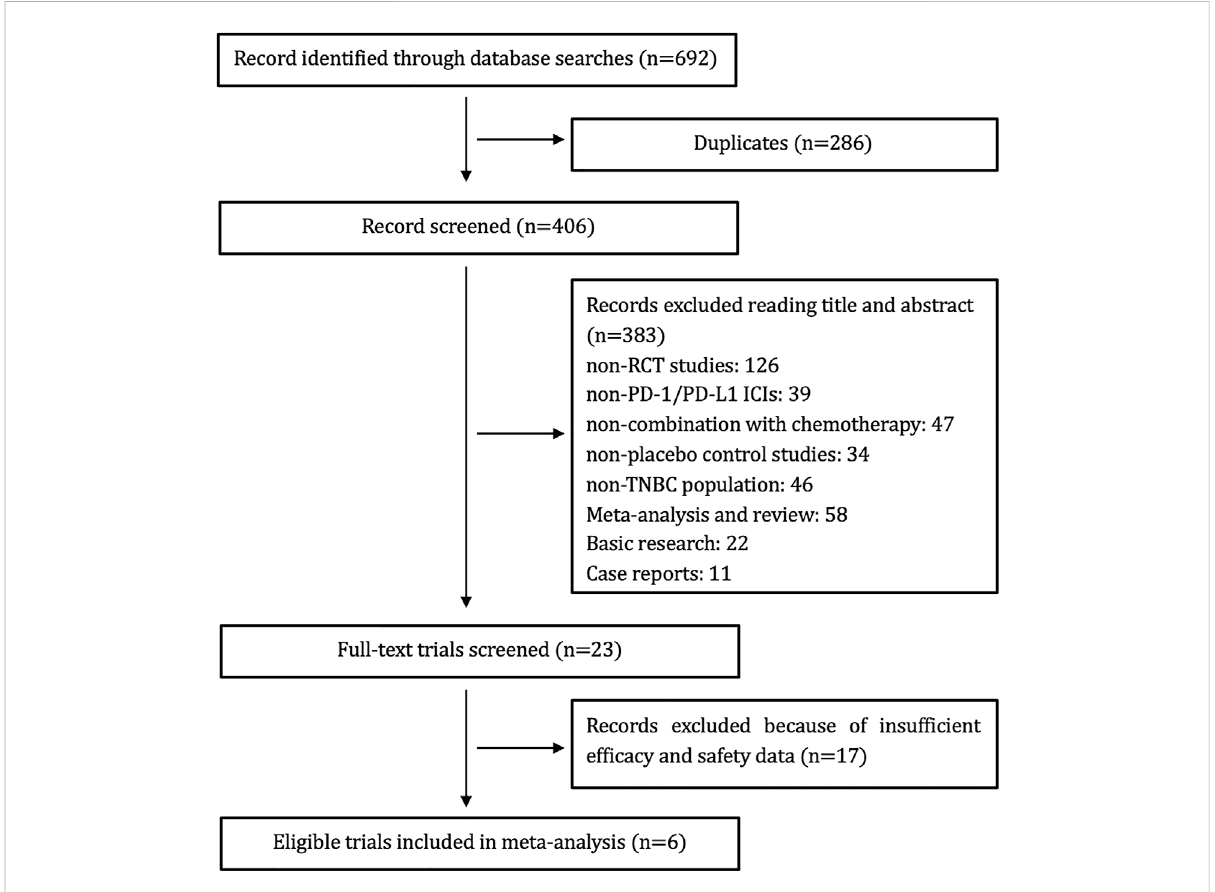
FIGURE 1 Flow diagram for identi fi cation and selection of studies included in the